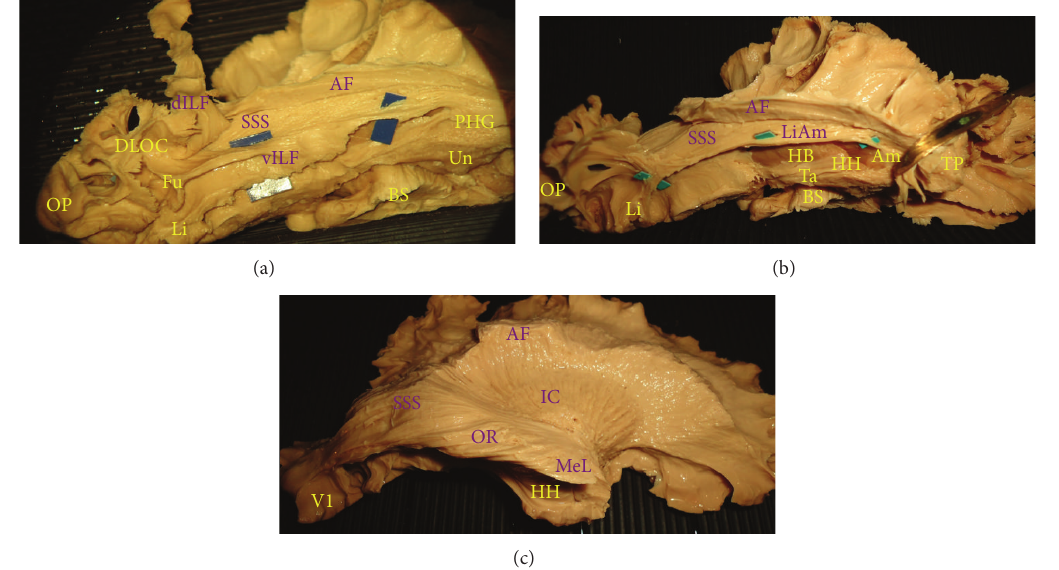
Figure 3: (a) Basal view of the right hemisphere showing the ventral portion of the ILF (vILF) with its double originating branches from the fusiform gyrus (Fu) and superficial lingual gyrus (Li). The bundle connects these two posterior basal regions to the parahippocampal gyrus (PHG). (b) Basal view of a right hemisphere after the removal of the dILF and vILF. The lingual-amygdala bundle (Li-Am/green) is completely exposed and its relationship with the ventricle and the sagittal stratum of Sachs (SSS) cranially is demonstrated. The Li-Am connects the lingual gyrus (Li) in an arch shaped bundle, which follows the wall of the lateral ventricle and at the level of the tip of the temporal horn turns medial to terminate in the inferolateral portion of the amygdala (Am). (c) Inferolateral view of a right hemisphere with the optic radiation (OR) completely exposed. The temporal loop of Meyer (MeL) is prominent anteriorly with respect to the other fibres. The optic radiation fibres run within the internal layer of the sagittal stratum of Sachs (SSS), inferior and lateral to the lateral ventricle, and turn medially to end at the level of the primary visual cortex (V1). The arcuate fasciculus (AF) and the internal capsule (IC) can be considered as superficial and deep landmarks, respectively. AF: arcuate fasciculus; BS: brain stem; HB: hippocampus body; HH: hippocampus head; OP: occipital pole; Ta: tapetal fibres; TP: temporal pole; Un: uncus